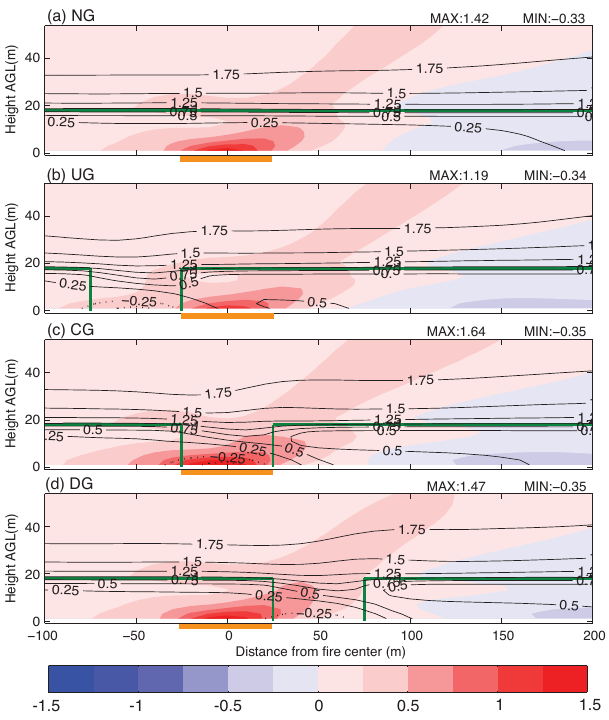
Figure 2. Vertical cross sections of the u component of the wind (ms − 1 ), averaged in time (30min) and space (along fire line); con- tours denote the no-fire case (0.25ms − 1 interval), and shading de- picts the difference between the fire and no-fire cases (0.25ms − 1 interval). The fire zone is denoted with an orange line, and the perimeter of the forest canopy is indicated with a green line. The maximum and minimum fire–no-fire difference for each case is in- cluded above each panel. Note that only a subset of the domain is displayed in each panel (100m upstream to 200m downstream of the fire center); see Fig. 1.